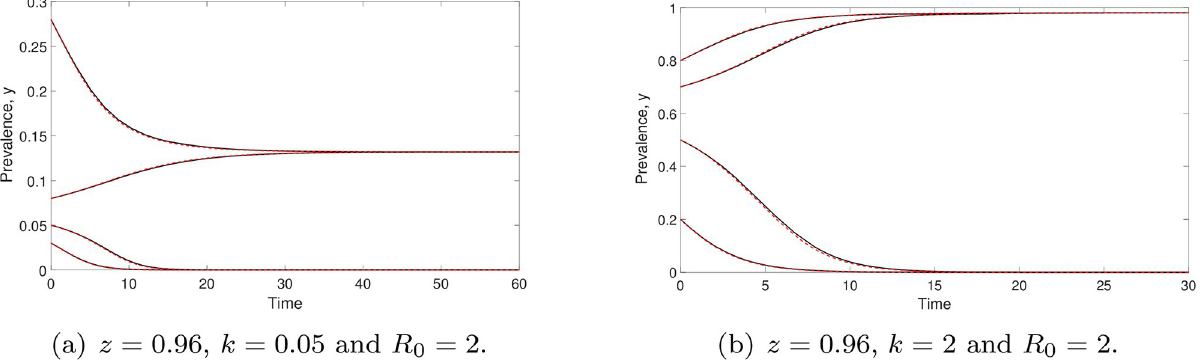
Fig 1. Comparisons of prevalence values generated by the models (3) (red dashed line) and (5) (black solid curve). Both models (prevalence-based or mean-worm-burden-based) produce well-matched results for arbitrary k and initial values. Both predict that the infection will either die off or reach an endemic